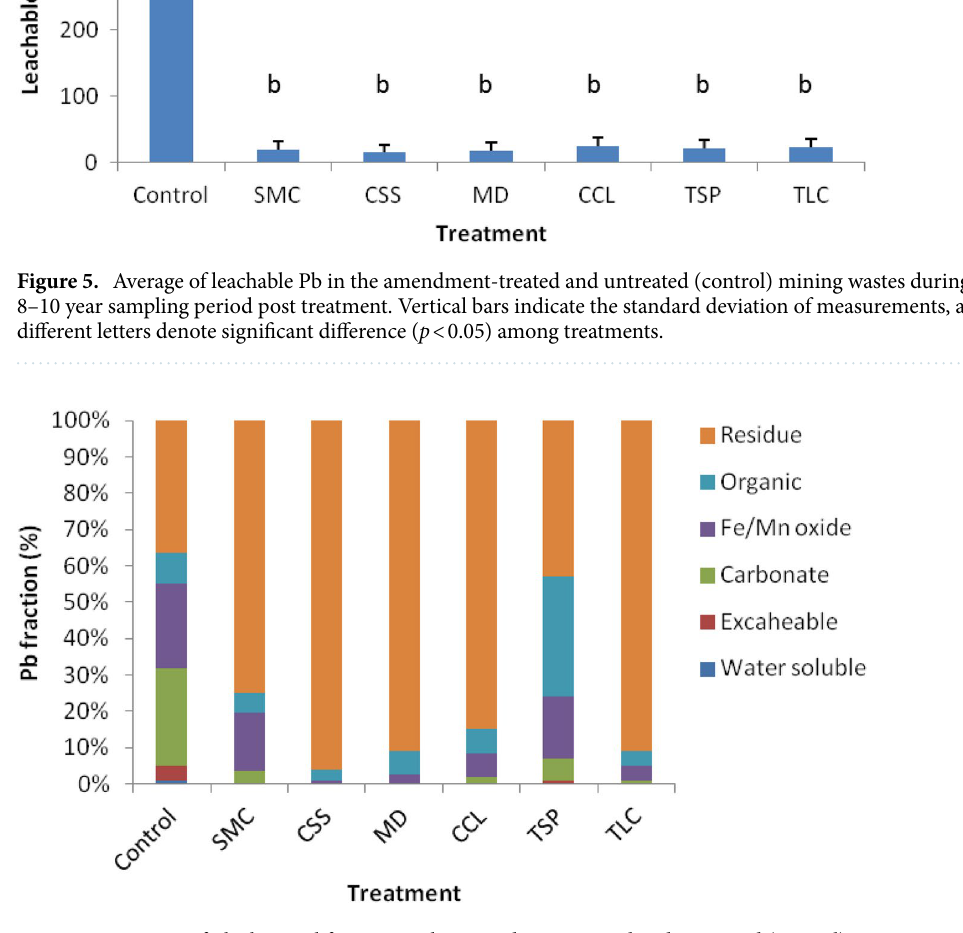
Figure 6. Average of Pb chemical fraction in the amendment-treated and untreated (control) mining wastes during the 8–10 year sampling period post